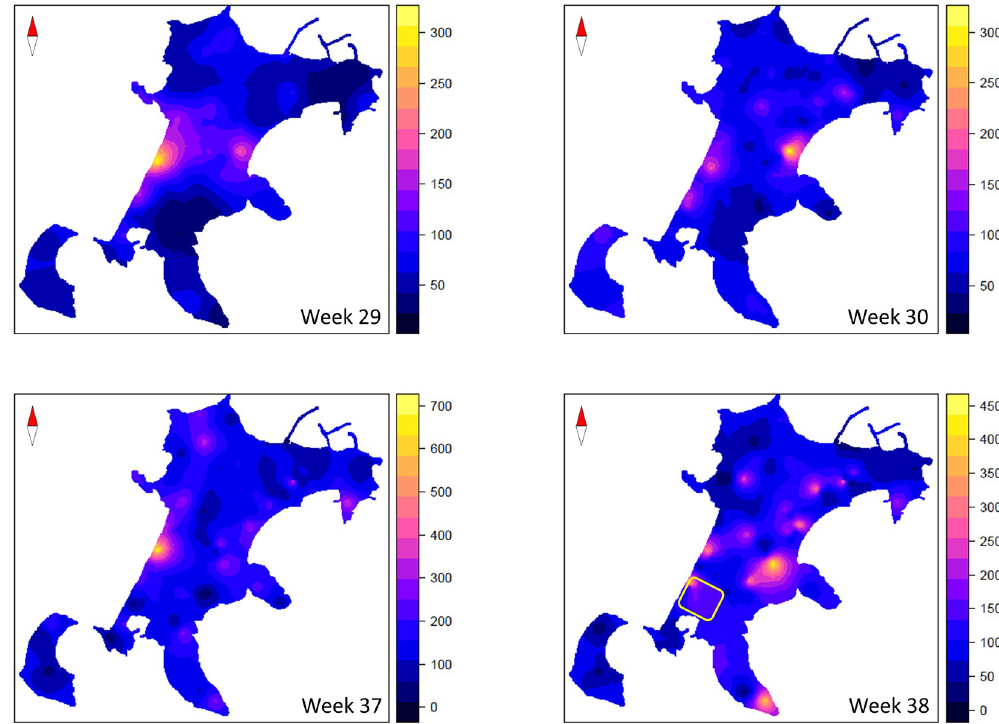
Fig 4. Ordinary Kriging maps of A . albopictus oviposition on Procida and Vivara islands. The figure shows the estimated ordinary kriging of Ae . albopictus oviposition on Procida Island in 4 weeks from July to September 2016. The colour gradient corresponds to the variation range of the estimated egg numbers. The yellow rectangle represents the area selected for the MRR experiments. The base layer of the geographic background map has been sourced from an open maps access (https://